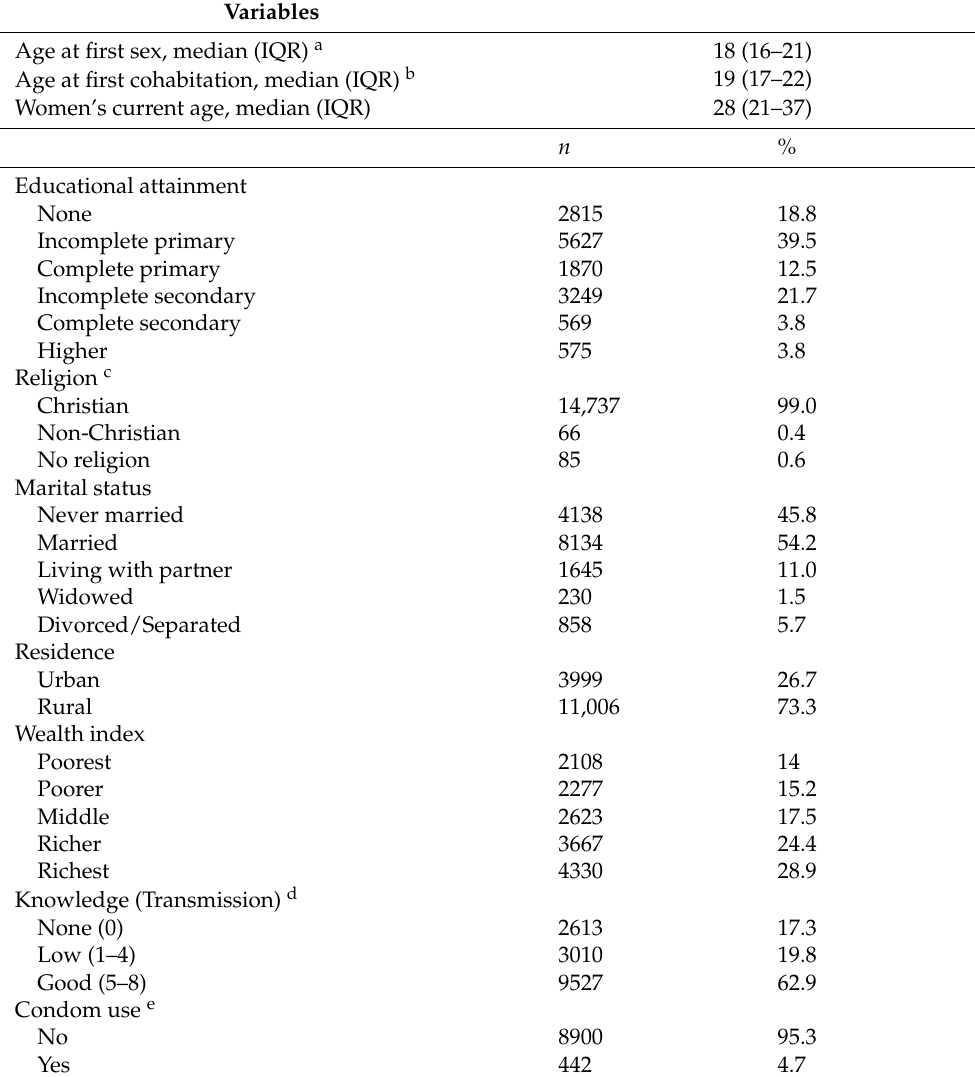
Table 1. Socio-demographics characteristics of the study